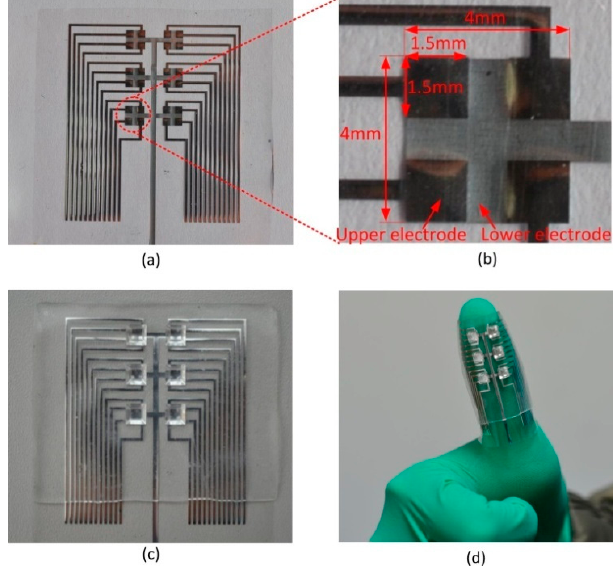
Figure 4. ( a ) Photograph of the fabricated PVDF film with patterned upper and lower electrodes; ( b ) magnified view close to electrodes of a tactile unit; ( c ) photograph of the fabricated three-axis tactile sensor array; and ( d ) photograph of the fabricated sensor array mounted on a curved surface.